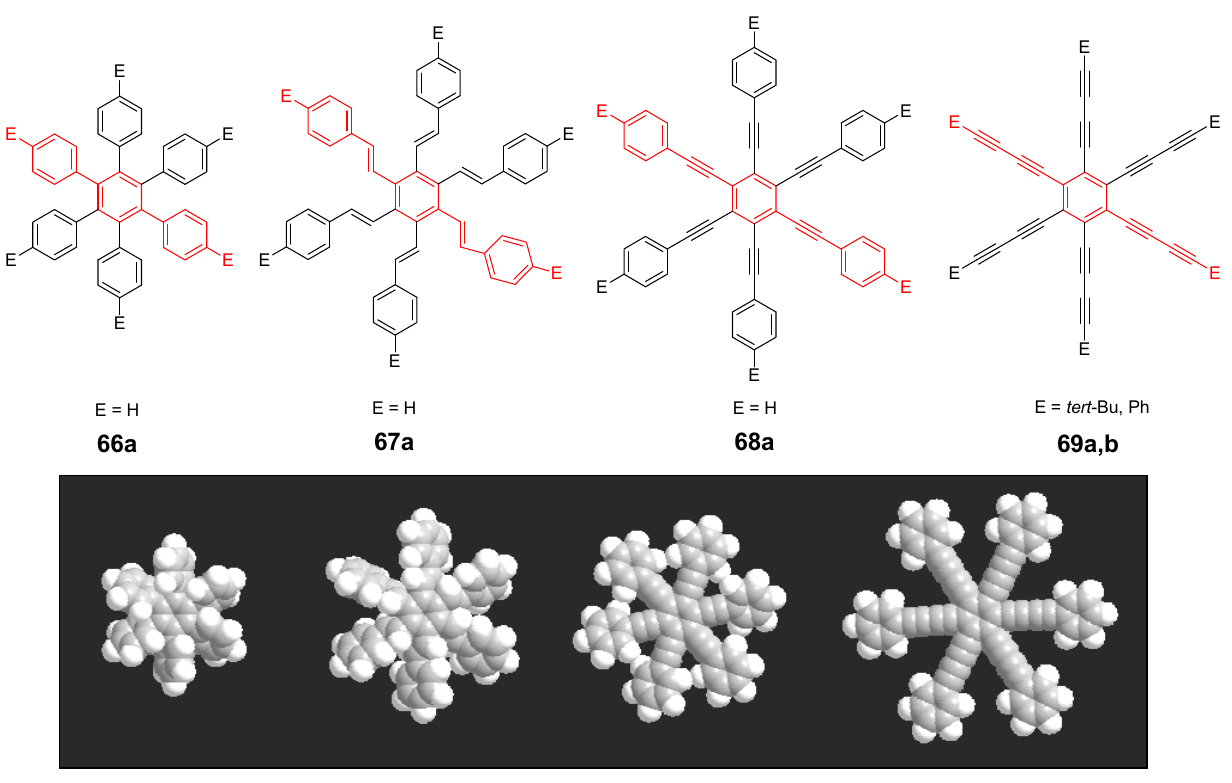
Figure 24. Parent, conjugated, hexasubstituted benzene compounds